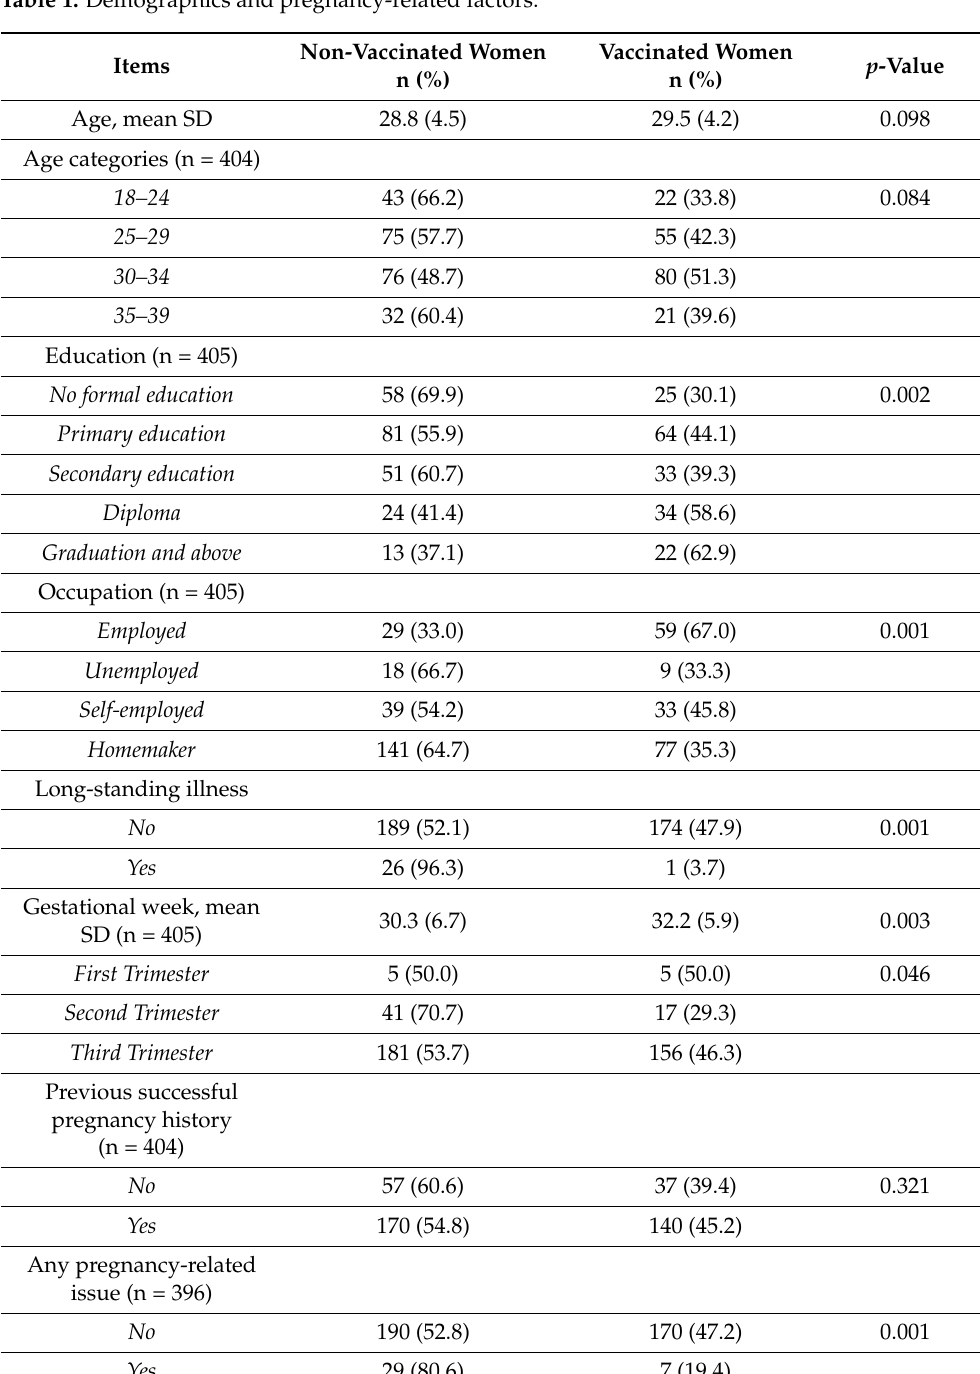
Table 1. Demographics and pregnancy-related factors.